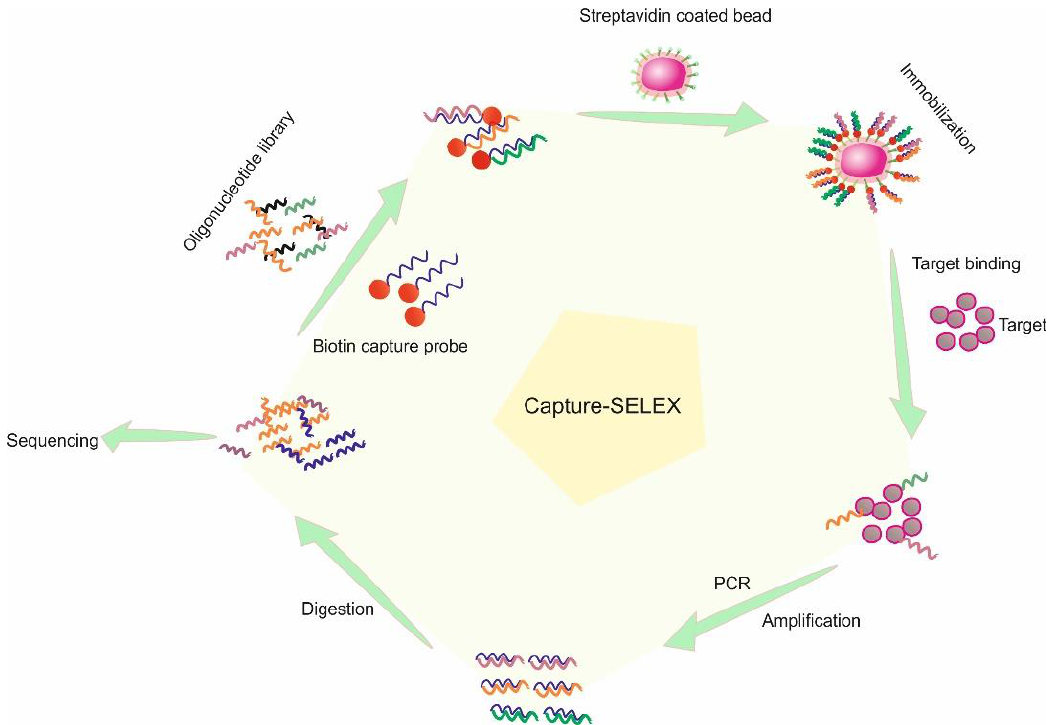
Figure 3. Schematic representation of Capture-SELEX.